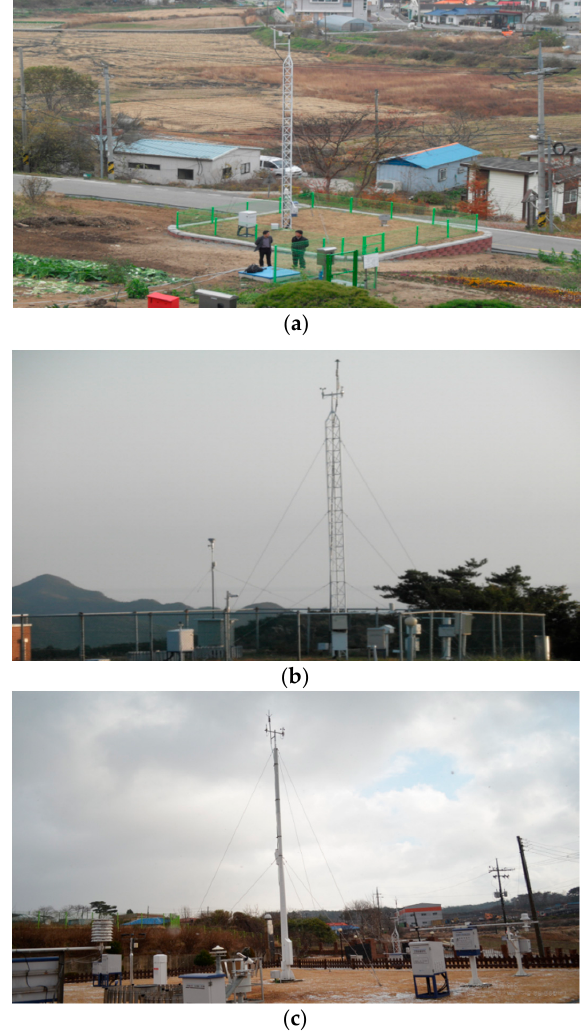
Figure 2. Meteorological masts for wind data measurement ( a ) Deokjeok-do; ( b ) Baengnyeong-do; ( c ) Seo-San.